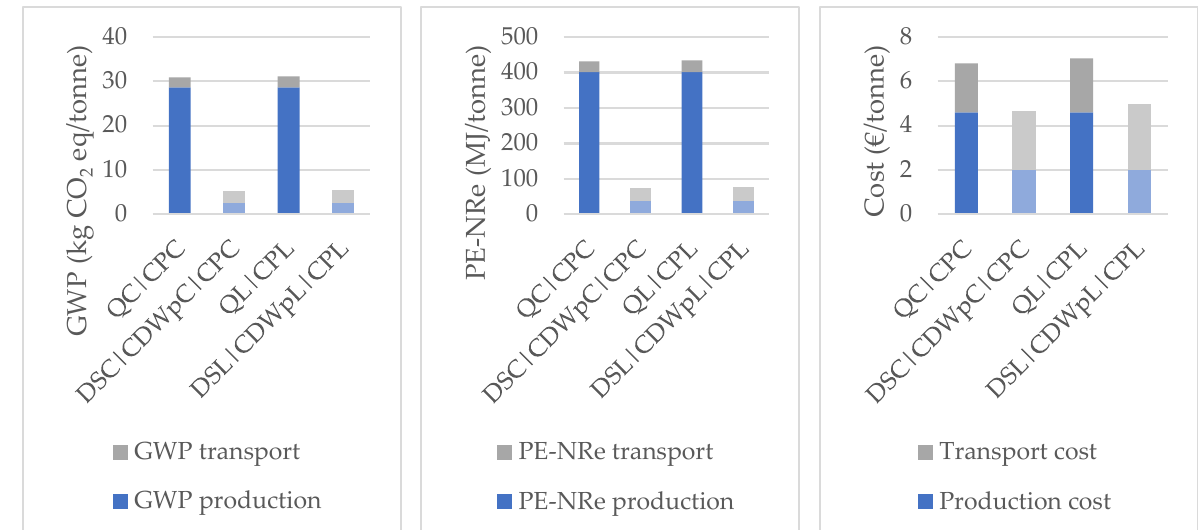
Figure 7. Comparison between Scenario 1, darker color, and Scenario 2a, lighter color.